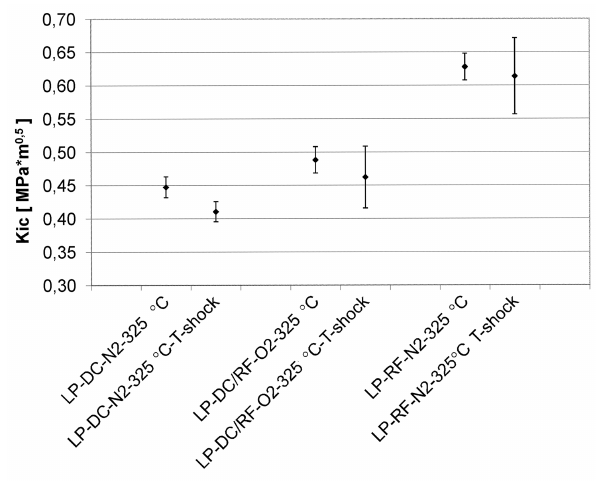
Figure 3. Fracture toughness before and after 100 temperature cy- cles between − 50 and 150 ◦ C.